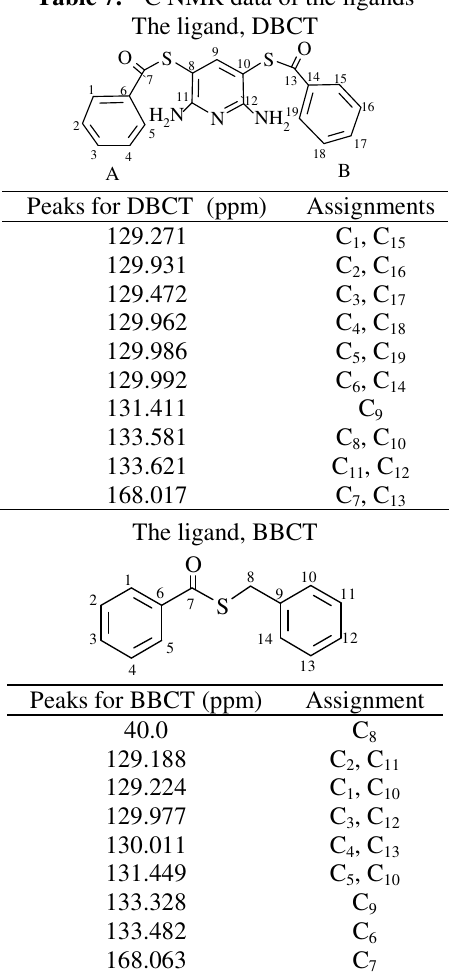
Table 7. 13 C NMR data of the ligands The ligand,